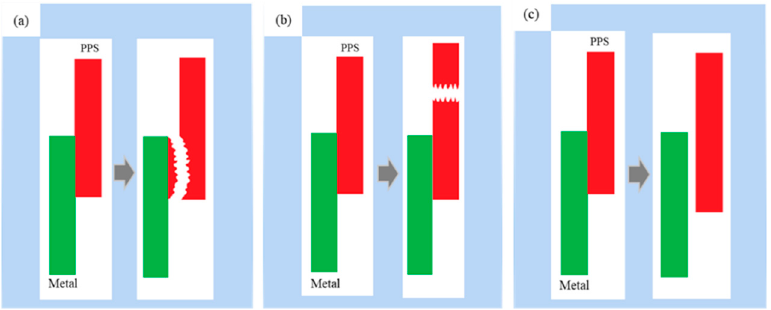
Figure 12. Schematic representation of three fracture models. ( a ) interface cohesive fracture; ( b ) polymer body fracture; ( c ) interface peeling fracture.